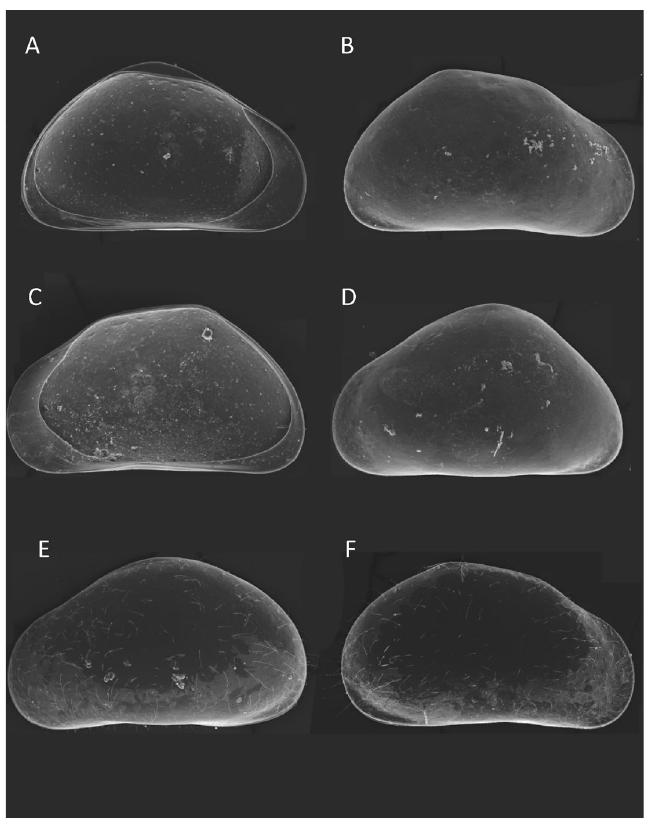
Figure 1. Pseudocandona movilaensis sp. nov. ( A ) Internal view of female left valve. ( B ) External view of female right valve. ( C ) Internal view of female right valve. ( D ) external view of female left valve. ( E ) External view of male left valve. ( F ) External view of male right valve (scale—200